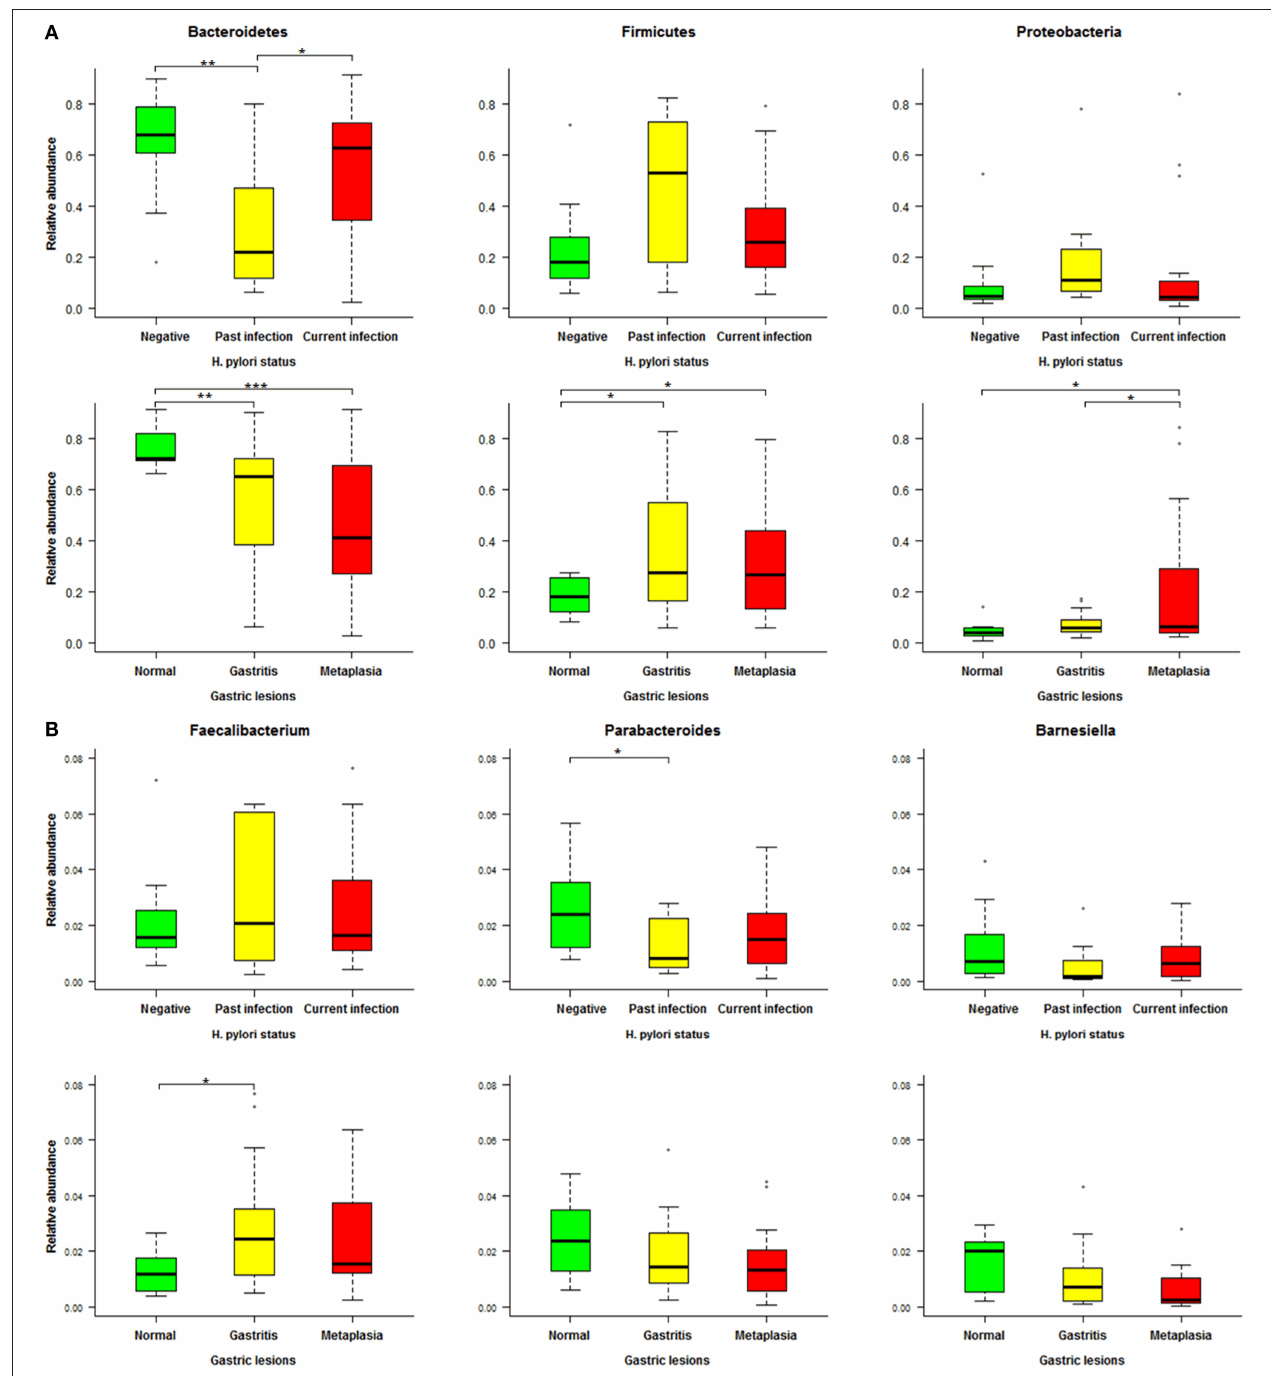
FIGURE 5 | Relative abundance distributions of specific phyla and genera in different Helicobacter pylori infection status and gastric lesion groups. (A) Boxplot of the main phyla in different H. pylori infection status and gastric lesion groups. (B) Boxplot of specific genera in different H. pylori infection status and gastric lesion groups. Significant differences between groups are indicated as *** p < 0.001, ** p < 0.01, and * p < 0.05, respectively.